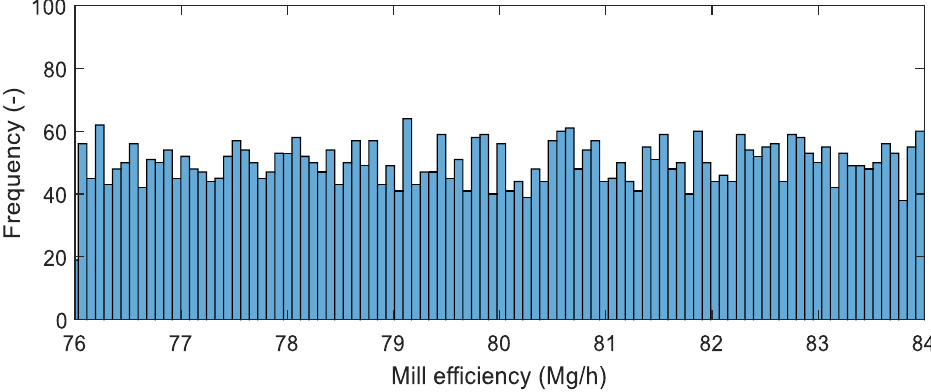
Figure 11. Bar chart of ball mill efficiencies (average value 80.02, standard error 0.033, standard deviation 2.32). Figure 12 is a schematic diagram of the simulation algorithm. The output of the model provides statistically represented energy-consumption